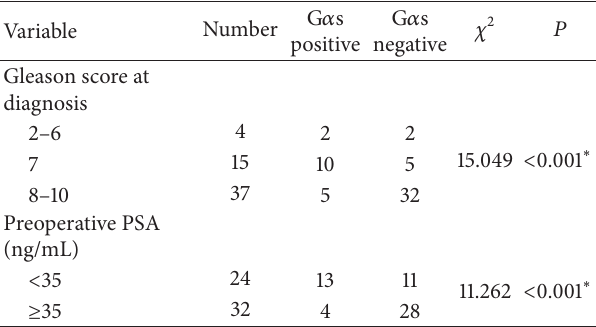
Table 4: Characterization of the cohort of 56 metastatic prostate cancer